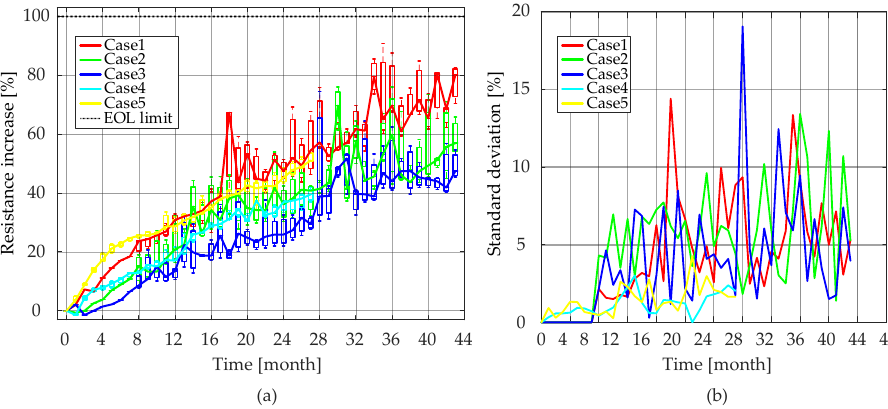
Figure 14 . Resistance increase curves of calendar-aged cells ( R i was calculated from 4C-rate discharging pulse at 80% SOC). ( a ) Boxplot of the resistance increase, ( b ) Standard deviation of the resistance increase.